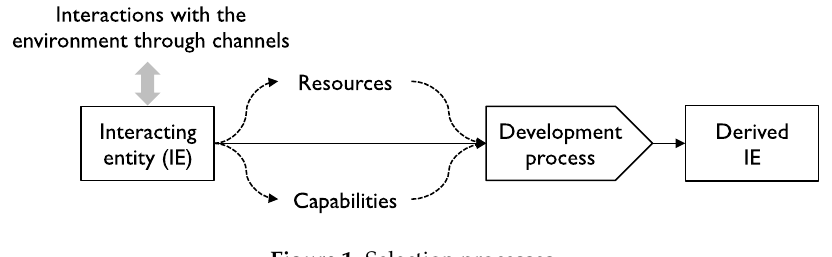
Figure 1. Selection processes.